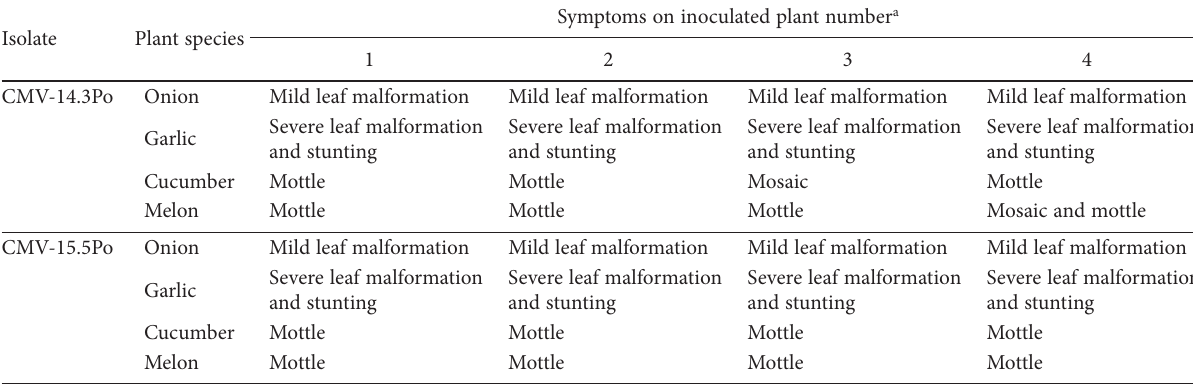
Symptoms on inoculated plant number a